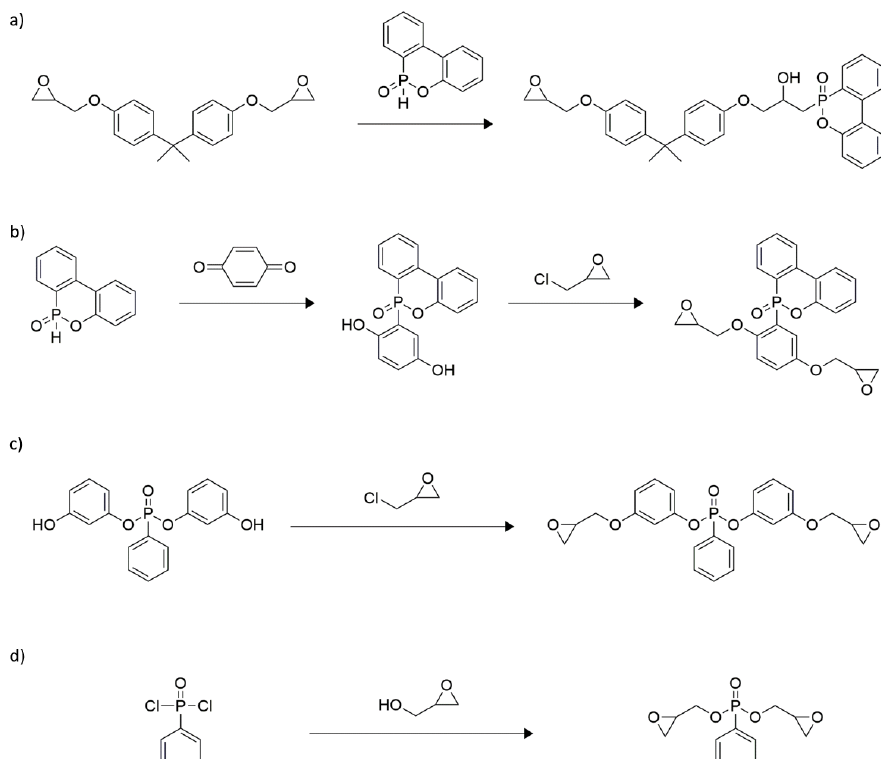
Figure 10. ( a ) Reaction with 9,10-dihydro-9-oxa-10-phosphaphenanthrene-10-oxide (DOPO) (phosphorus-containing flame retardant) and bisphenol A diglycidyl ether (BADGE) (epoxy resin); DOPO is the most commonly used co-monomer used to react with the oxirane ring of the epoxy component. ( b ) Reaction with DOPO modified by benzoquinone containing phenols (phosphorus-containing flame retardants) and epichlorohydrin (epoxy resin); T g of the epoxy resin can be reduced by the co-monomers decreasing the cross-linking density. ( c ) Reaction with alcohols/phenols (phosphorus-containing flame retardants) and epichlorohydrin (epoxy resin), which is widely used as an industrial reactant; (2,5-dihydroxyphenyl) diphenyl phosphine oxide (Gly-HPO) produced by this reaction increases the limiting oxygen index (LOI) of the epoxy resin. ( d ) Reaction with (oxy)chlorides (phosphorus-containing flame retardants) and glycidyl alcohol (epoxy resin), which is an easy method to synthesize phosphorus-containing epoxy components. Reprinted with permission from Ref. [129]. Copyright 2014, Springer.